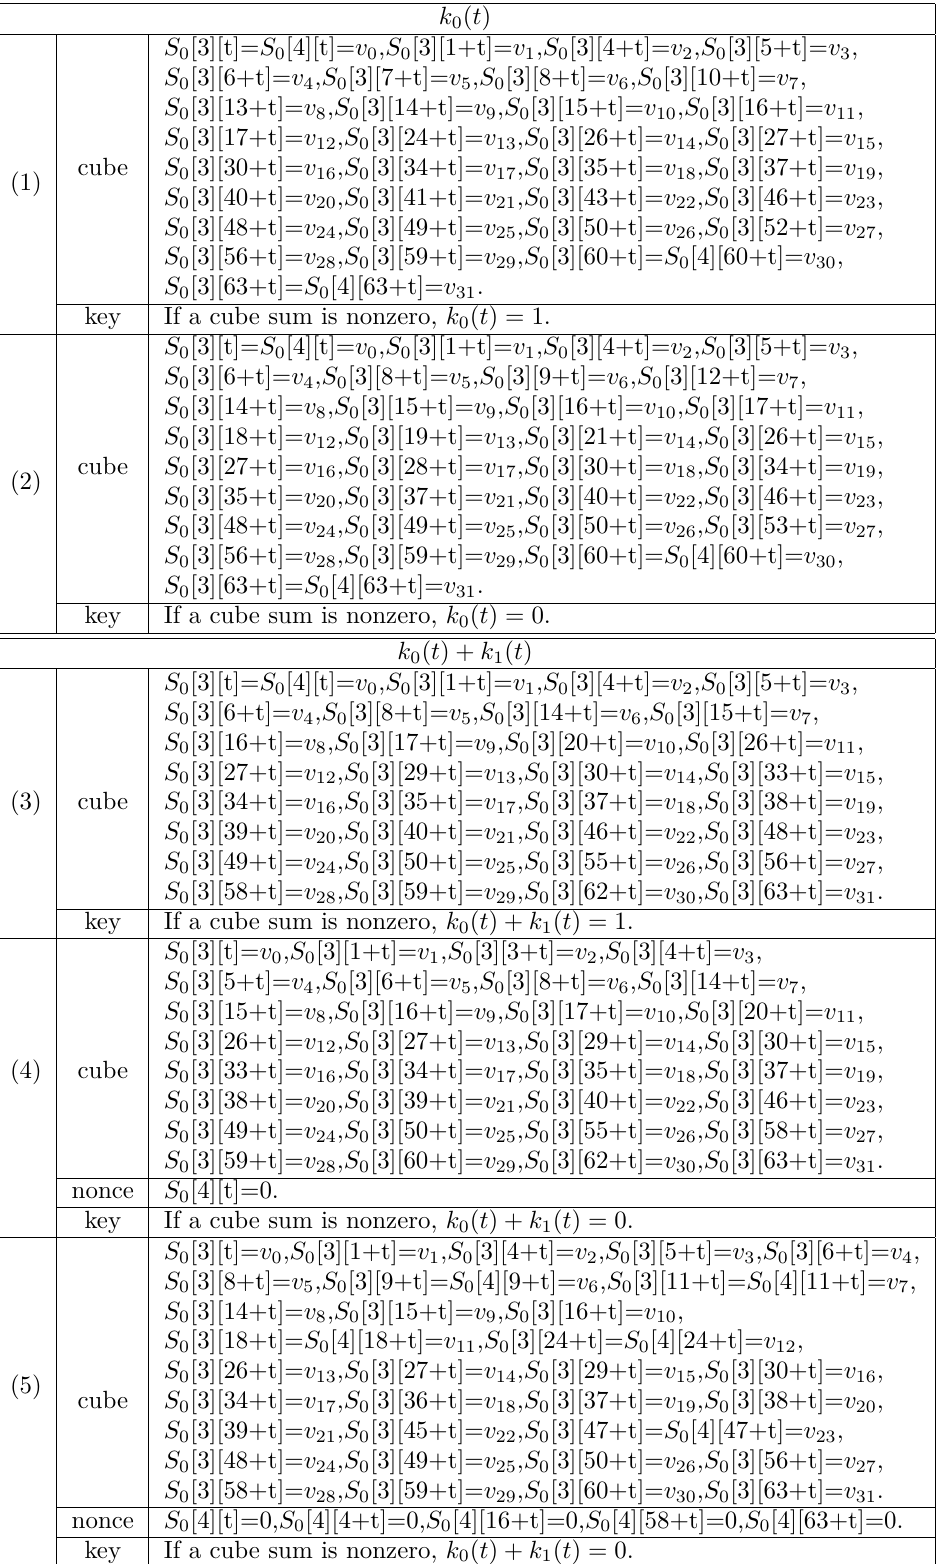
Table 8: Parameters Set for Attack on the 6-round Initialization of Ascon k 0 ( t